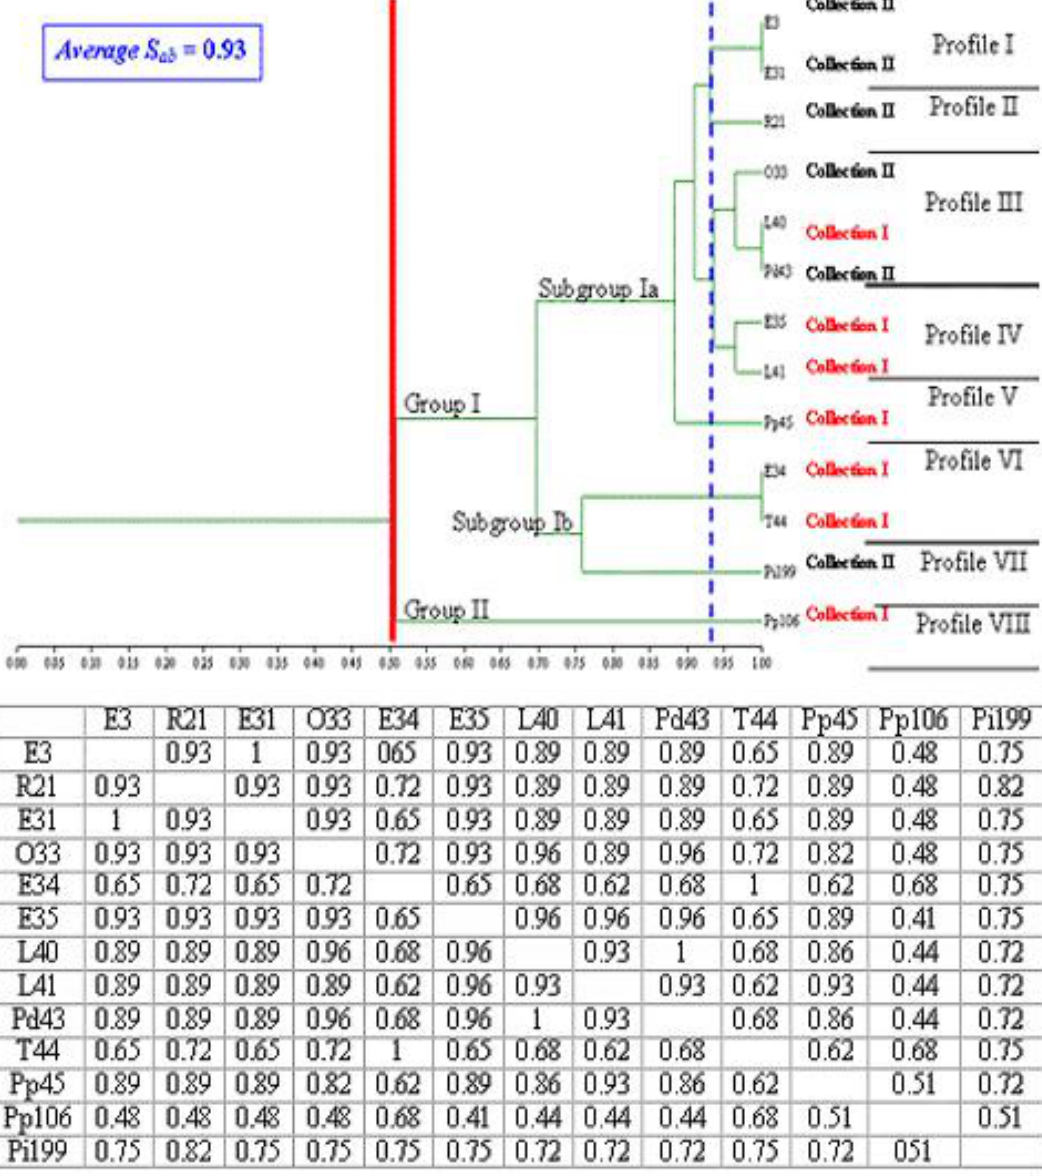
coefficients, showing the genetic similarity ab average indicated by dotted ab